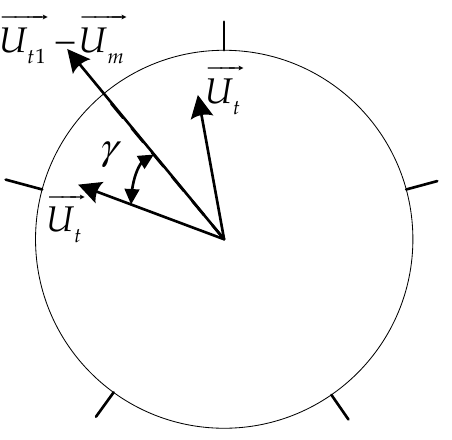
Figure 9. Milling at multiple positions.